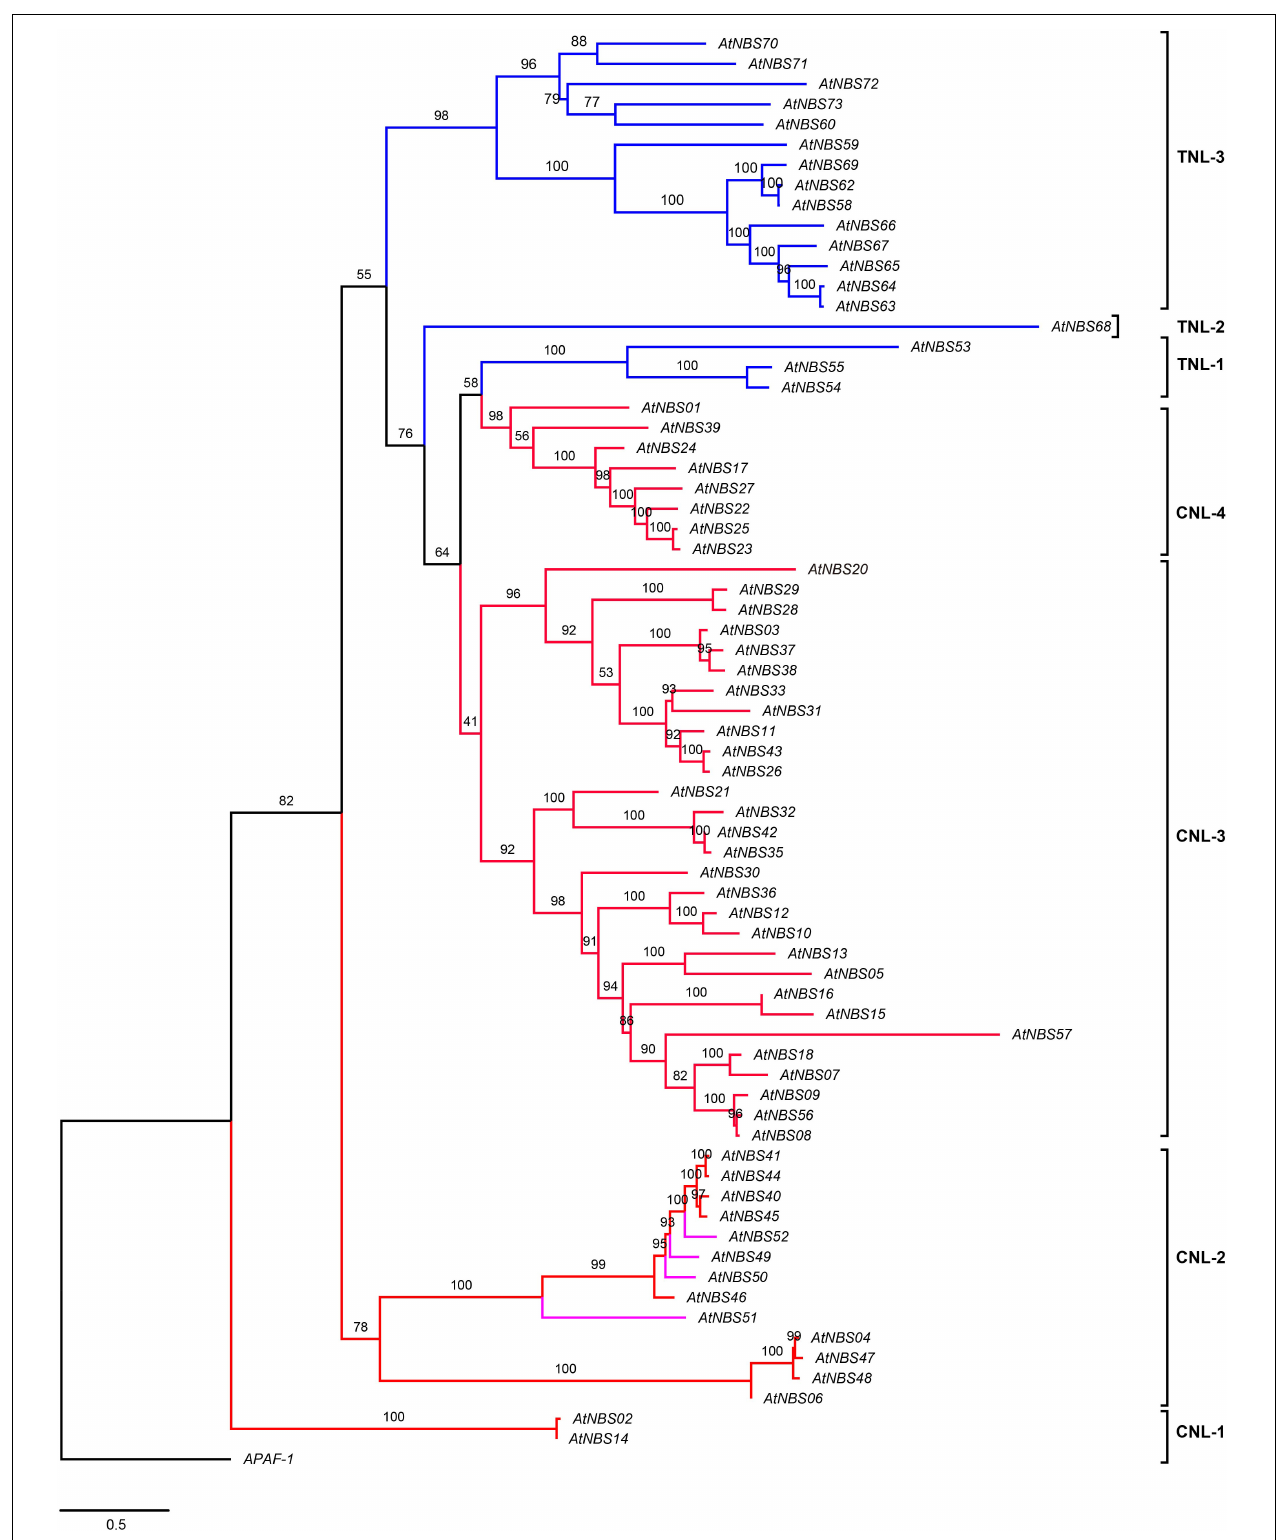
FIGURE 3 | Phylogeny of NBS genes in A. trifoliata . The maximum likelihood tree was constructed using 70 NBS domains, both here and below. Percent bootstrap values (1000 iterations) are indicated in every branch. Blue, red, and pink lines correspond to the TIR, CC, and RPW8 clades, respectively. APAF-1 was used as an outgroup. The scale bar indicates the genetic